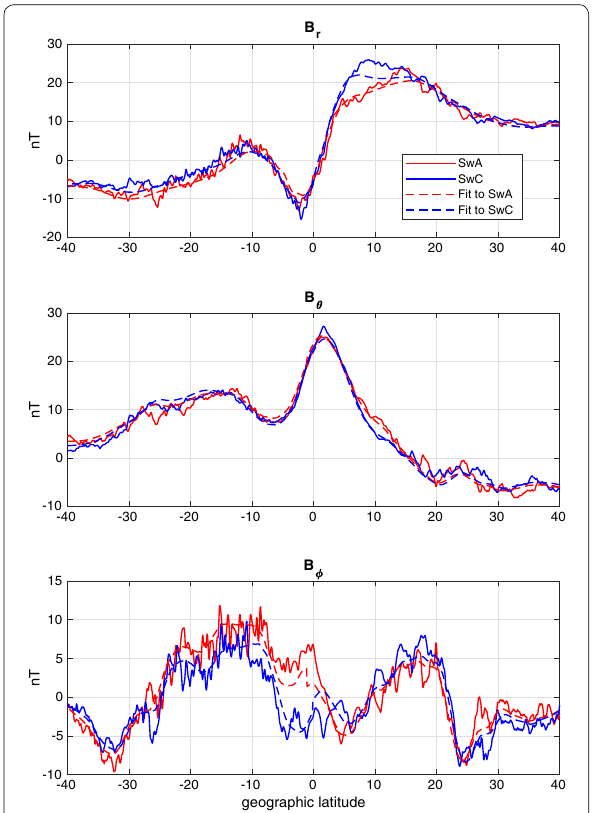
Fig. 6 Event E2. Red and blue solid lines show the magnetic field components measured by Swarm-A/C, respectively, while the dashed lines show the fit from the Swarm/DECS